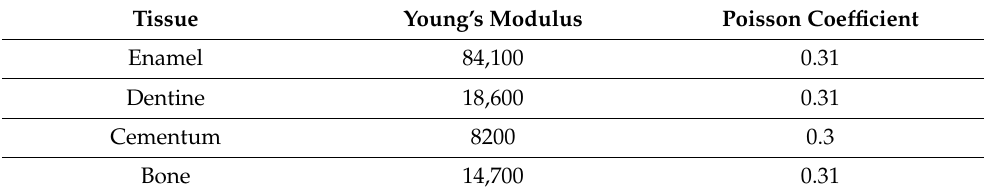
Table 1. Young’s modulus and Poisson coefficient of dental and supporting tissues.